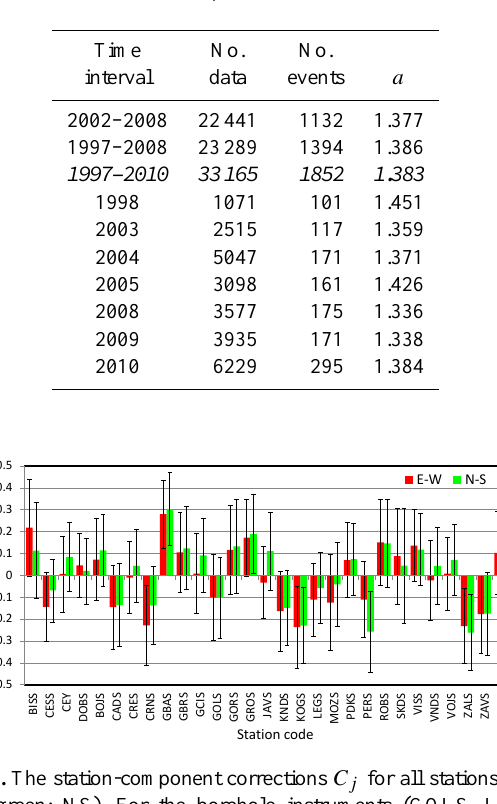
data available on vertical ground velocity seismograms as well as on simulated horizontal displace- ment seismograms are selected. Next both magnitudes are calculated for all 922 such events in the time interval of 14 years, from 1997 to 2010. For each earthquake both magnitudes are drawn as a 205 point coordinates in Fig. 5. Linear regression is used to find the relation between the two magnitudes.